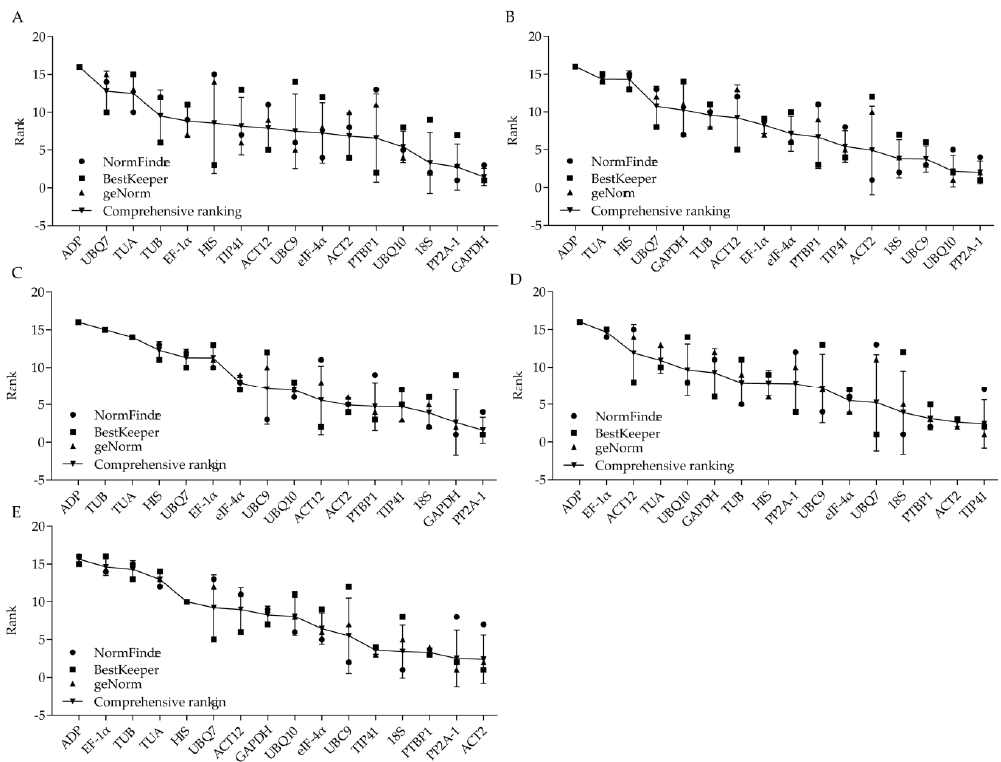
Figure 4. Comprehensive ranking of the 16 RGs in L . olgensis calculated as the geometric mean of three types of ranking (geNorm, NormFinder, and BestKeeper) for each sample group. ( A ) Drought stress. ( B ) Salt stress. ( C ) Cold stress. ( D ) Heat stress. ( E ) All samples.